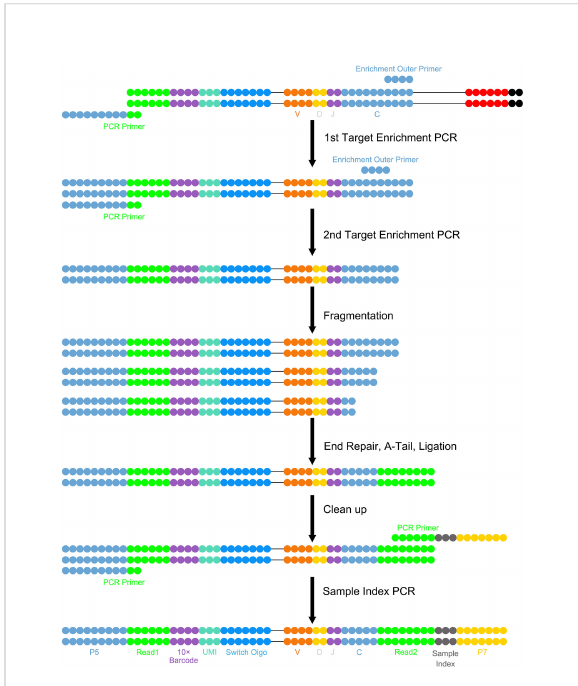
FIGURE 1 Schematic diagram of single-cell TCR/BCR sequencing